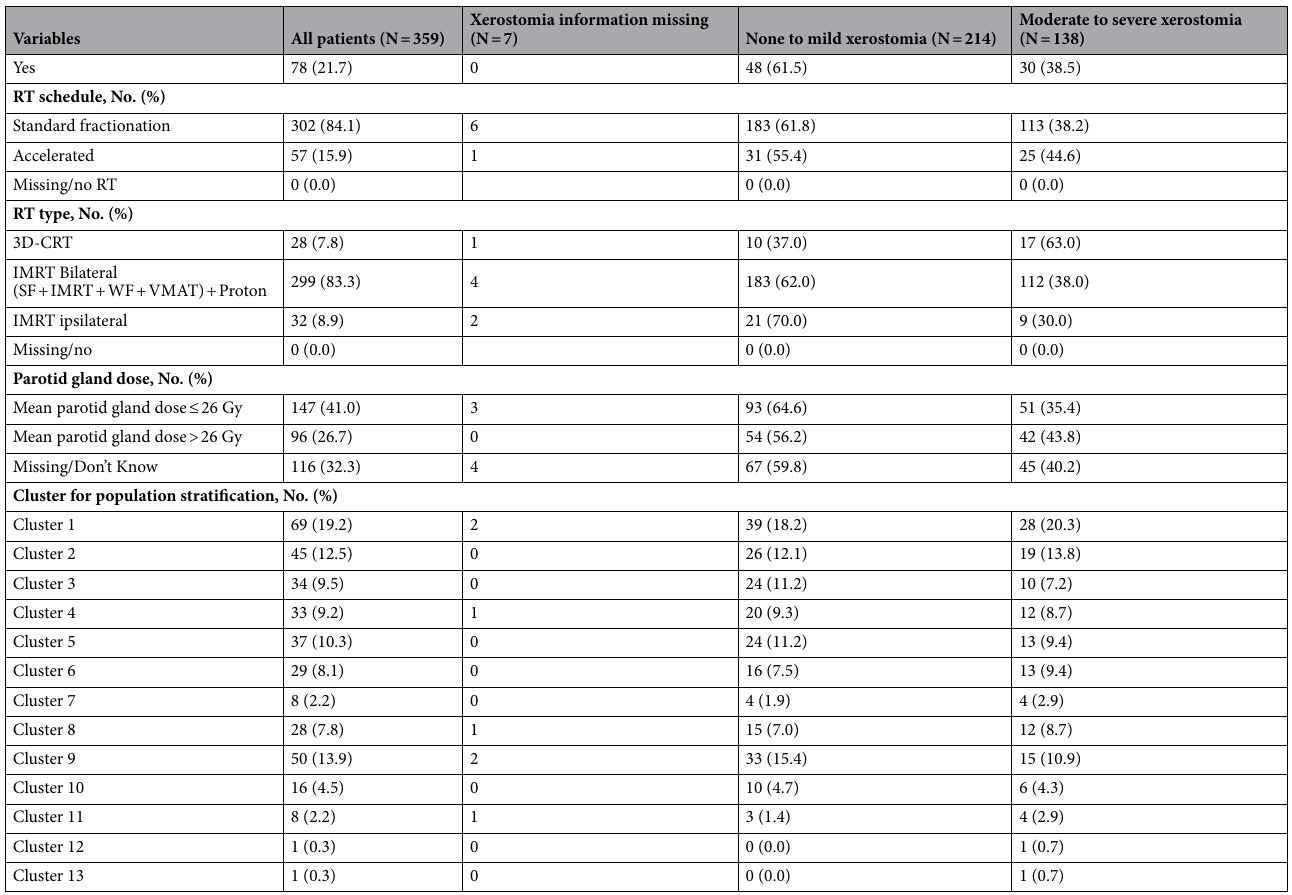
Table 1. Characteristics and distribution of oropharyngeal cancer patients by clinical and demographic factors. 3D-CRT, three-dimensional conformal radiotherapy; GPS, glossopharyngeal sulcus;